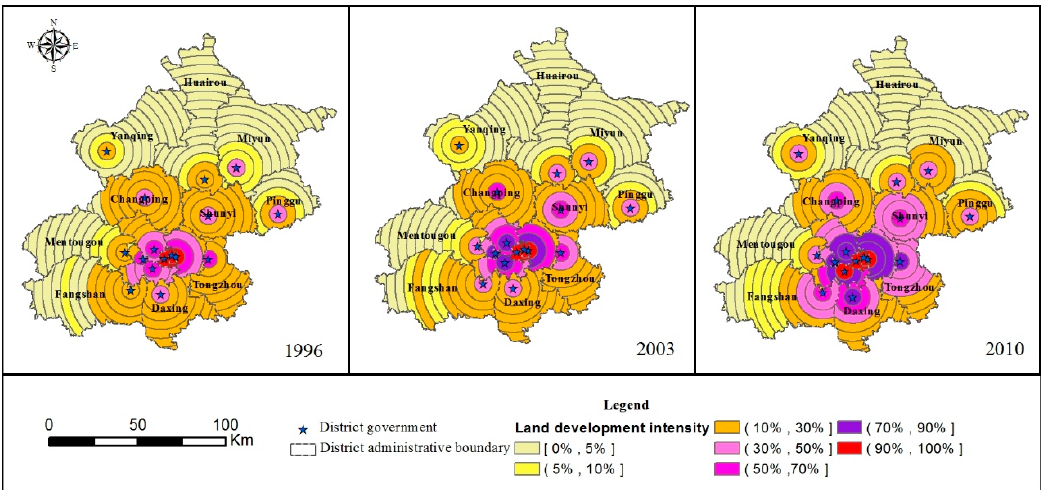
Figure 8. Land development intensity in buffer rings around the district and county governments.